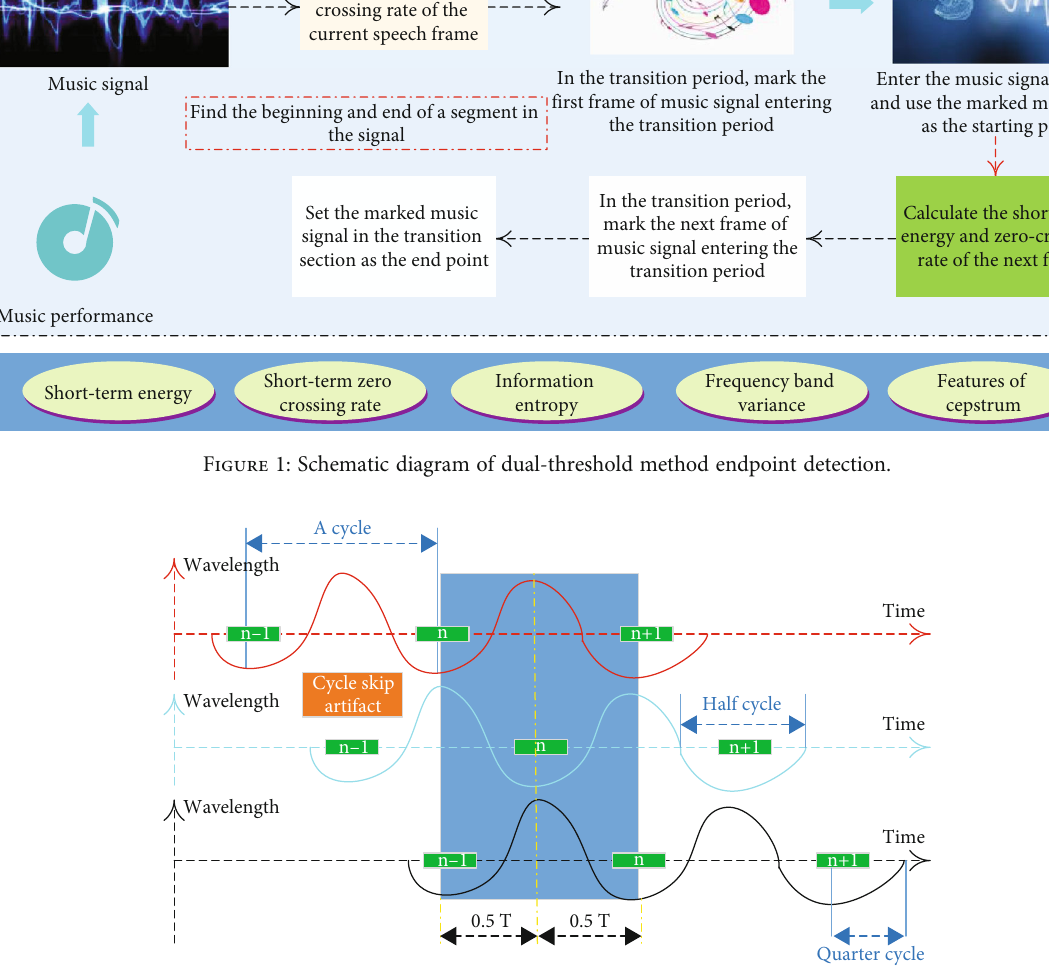
Figure 2: Schematic diagram of cycle